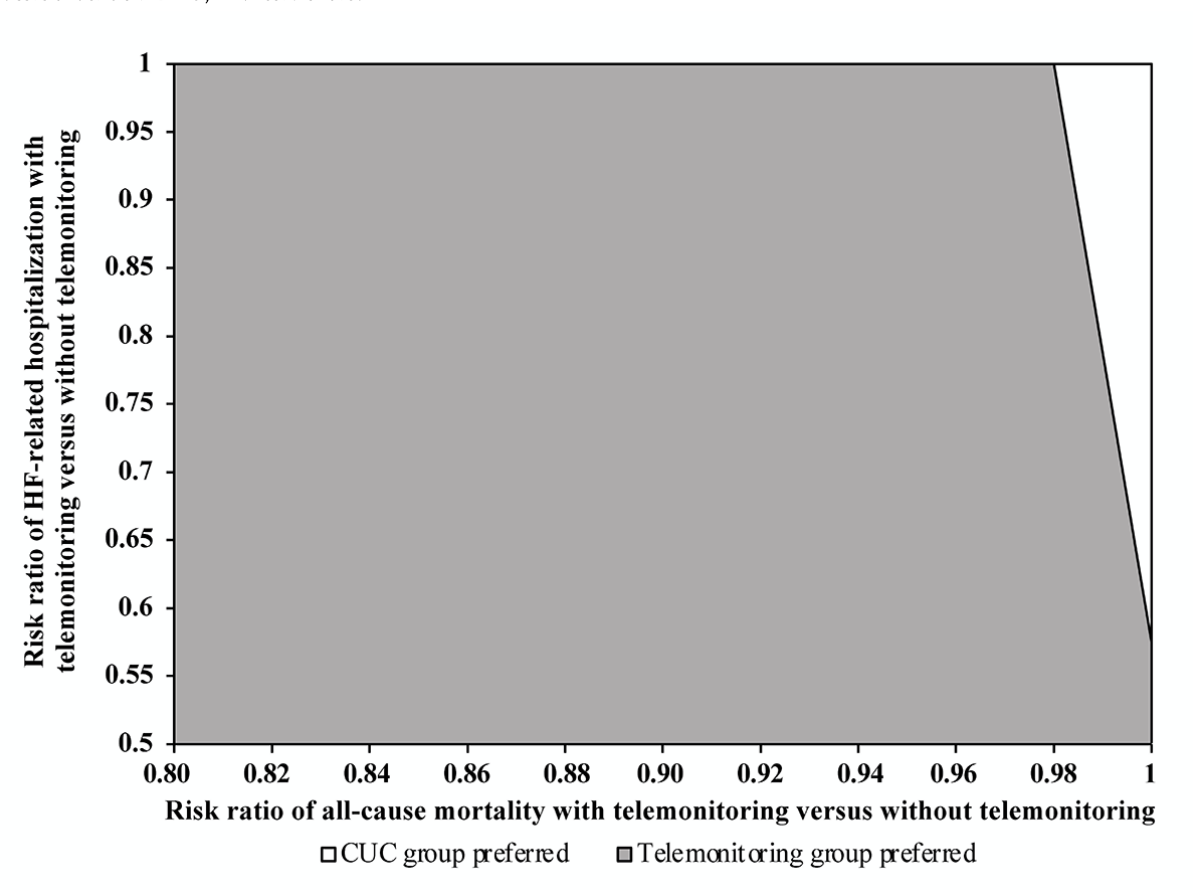
Figure 3. Two-way variation of the risk ratios with telemonitoring versus without telemonitoring on HF-related hospitalization and all-cause mortality. CUC: care under COVID-19; HF: heart